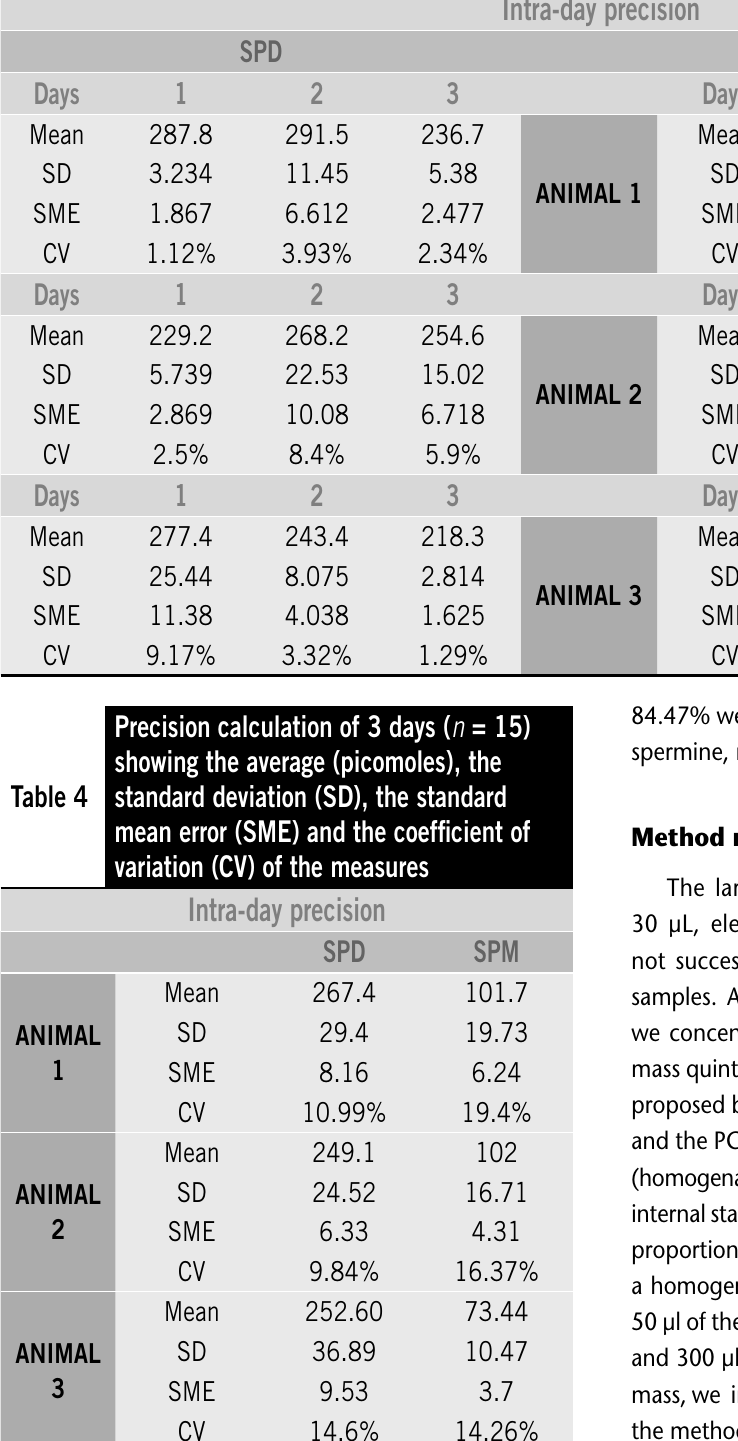
Intra-day precision in quintuplicate showing mean (picomoles), standard deviation (SD), standard Table 3 mean error (SME) and coefficient of variation (CV) of the measures Intra-day